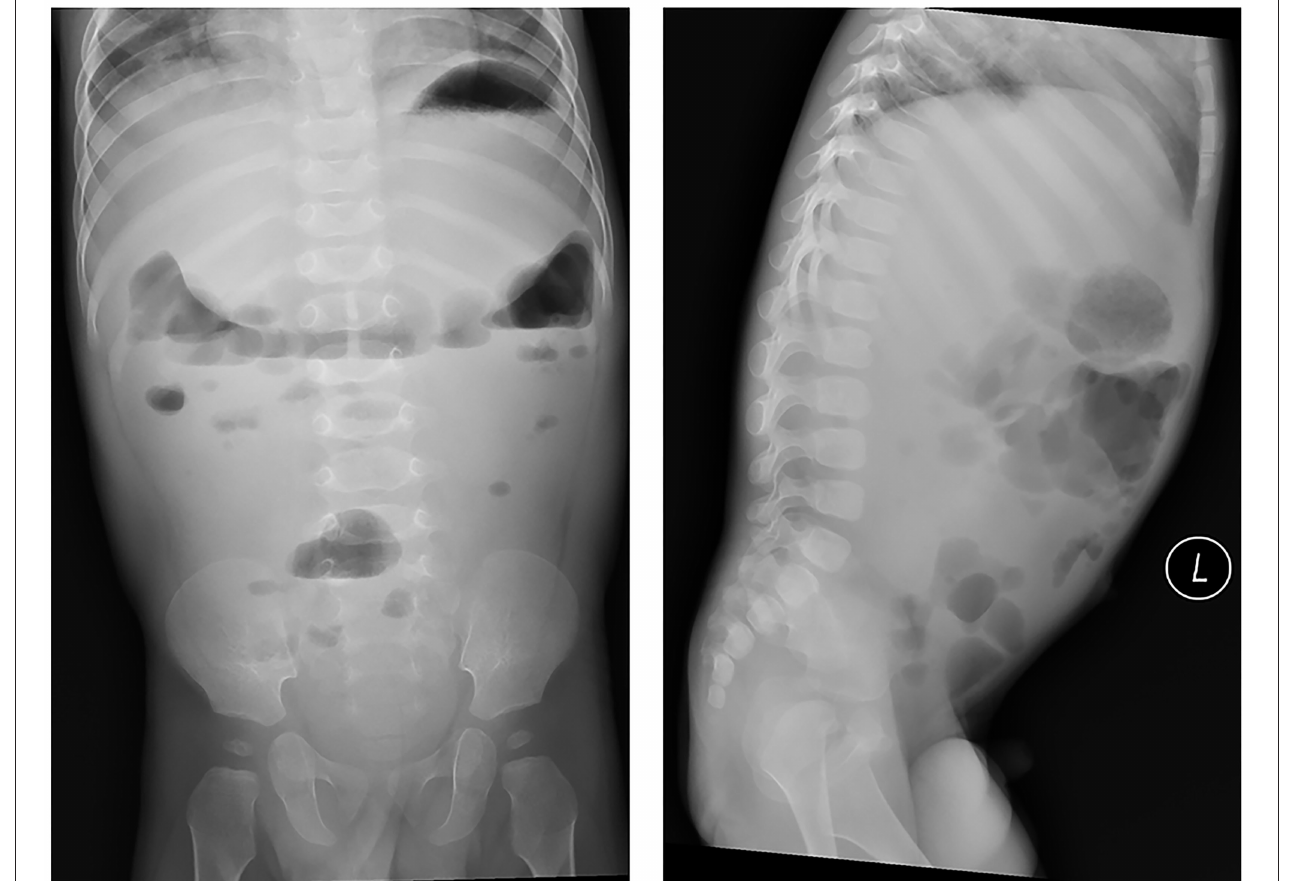
FIGURE 1 | Abdominal radiographs suggested intestinal motility changes without any signs of intestinal